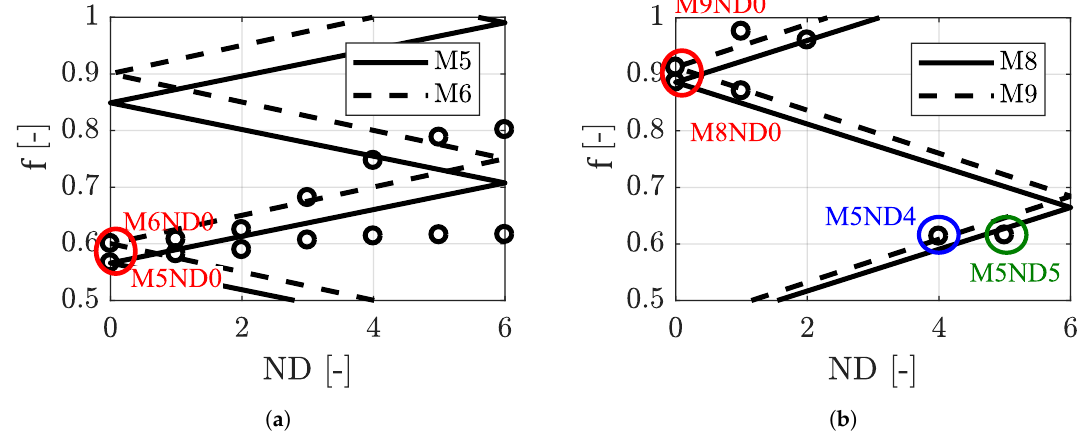
Figure 2. Numerical ZZENF Diagrams. ( a ) ZZENF diagram with rotational speeds of M5 and M6 (excitation at EO24 and ND0); ( b ) ZZENF diagram with rotational speeds of M8 and M9 (excitation at EO24 and